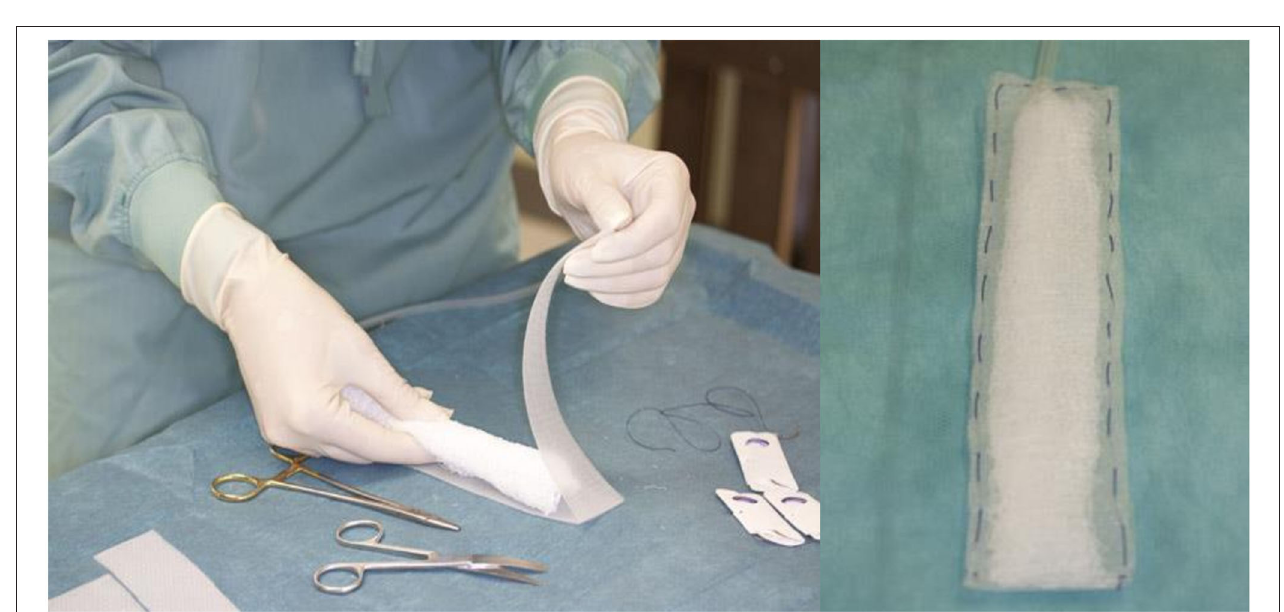
FIGURE 2 | Production of the suction